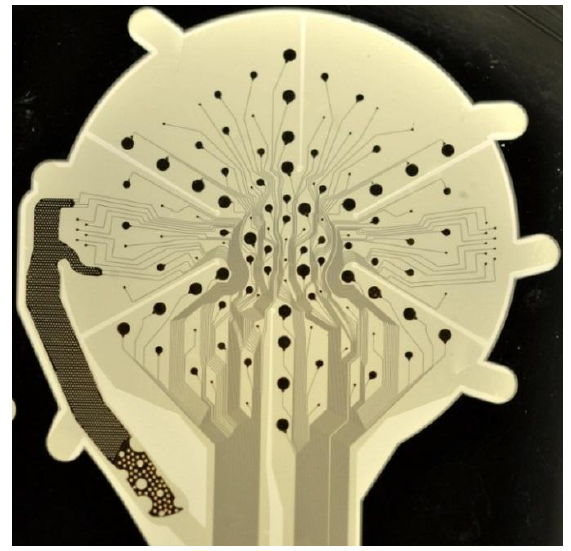
Figure 7. ECoG signal-acquisition